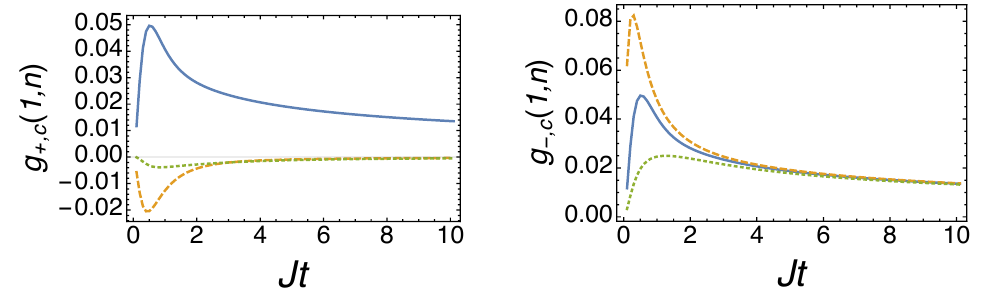
( 1, n ) as functions of time for n = 1 (solid blue), Figure 4: Connected correlators g σ , c n = 2 (dashed yellow), n = 3 (dotted green) on a ring of L = 36 sites. The correla- tions are very